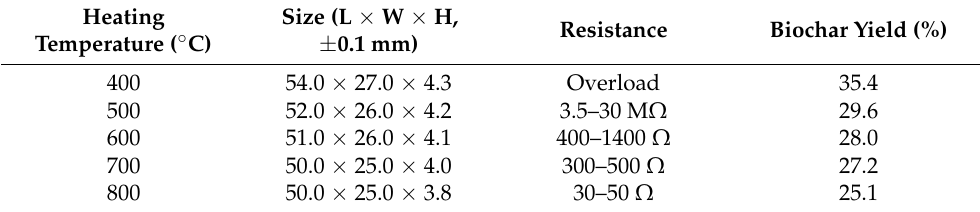
Table 1. Biochar size and